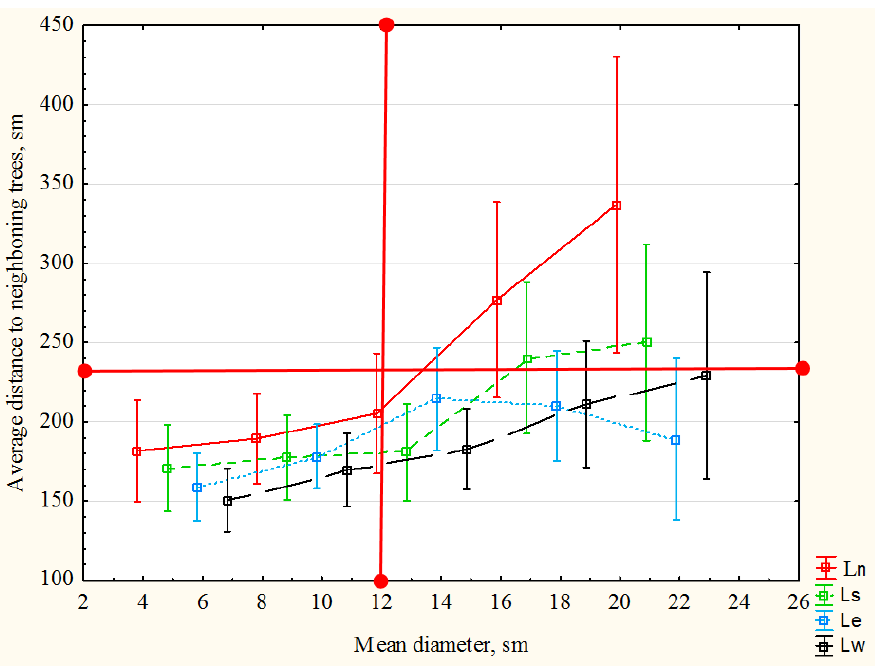
Figure 9. Dependence of DBH on the distance to neighboring trees according to the geographical orientation.